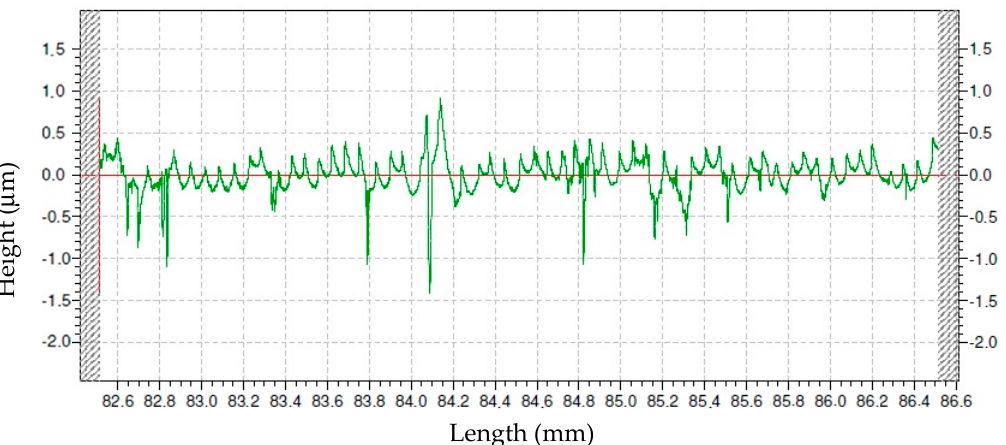
Figure 13. Graphical representation of the measured profile of the milled cam in Segment 1.